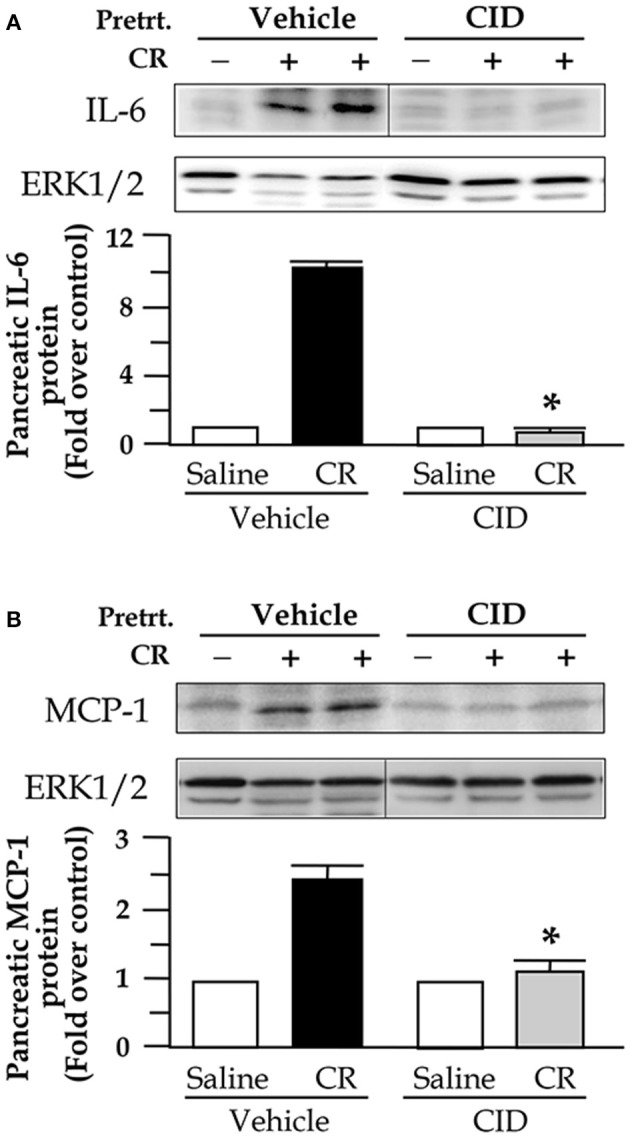
CID755673 (CID) pretreatment decreases pancreatic levels of IL-6 and MCP-1 in cerulein (CR)-induce pancreatitis. Western blot was performed to analyze pancreatic levels of IL-6 and MCP-1 in the tissue lysates using antibody against rat IL-6 (A) or MCP-1 (B). ERK1/2: for loading controls. The Western blot band intensities were quantified and normalized by the loading controls and expressed as the ratio over the untreated control in the bar figures. Bar values are means ± SE, *p < 0.05 vs. rats without CID treatments in CR-induced pancreatitis. (A,B) Samples were run in a single gel but were not continuous, as indicated by a line between lanes.